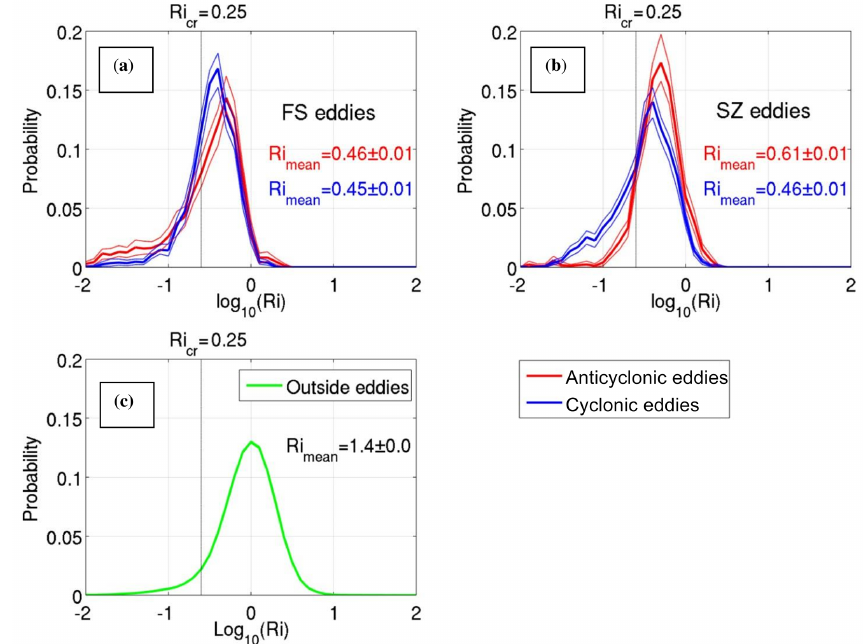
Figure 12. Probability distribution function of Richardson numbers ( Ri ) estimated for Fram Strait (FS) eddies (a) , Severnaya Zemlya (SZ) eddies (b) , and using M1f mooring observations after eliminating identified eddy events (c) . Vertical dashed lines indicate the criti- cal Richardson number ( Ri cr ), which separates areas of stable and unstable (turbulent) flow. Red and blue dotted lines indicate the 95% confidence interval estimated by the bootstrap method. The 95 % confidence intervals in (c) are indistinguishable at these